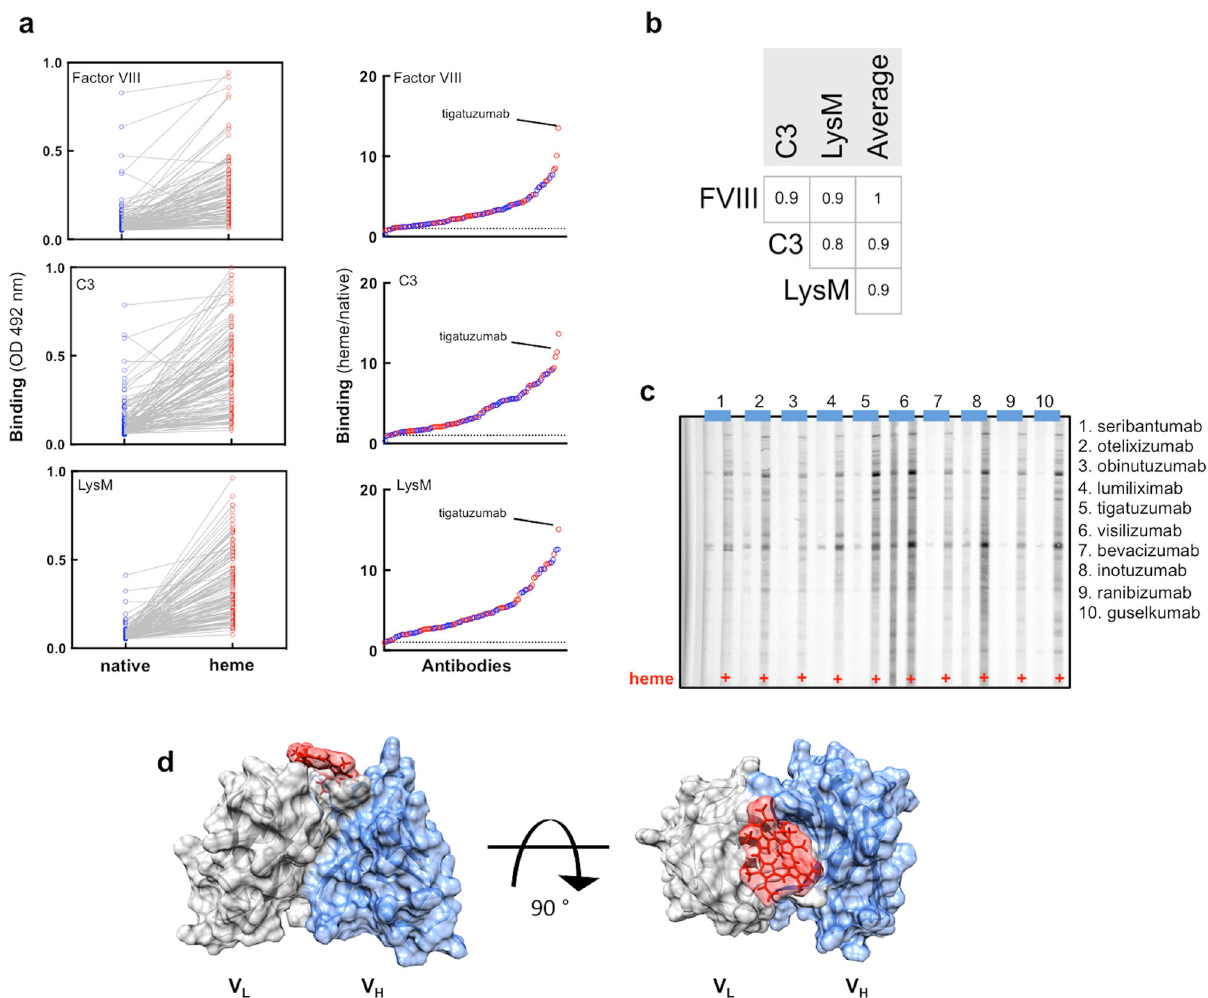
Fig. 3 Heme-induced antigen-binding polyreactivity of Abs. a ELISA analysis of the binding of the repertoire of therapeutic Abs to immobilized human (FVIII, C3) and bacterial (LysM AtlA) proteins. Each circle depicts the average reactivity of an individual Ab obtained from duplicate samples. The right panels show the global reactivity pro fi le of the repertoire of therapeutic Abs. The protein binding intensity was obtained by dividing the reactivity of given Ab after exposure to heme by the reactivity of the same Ab in its native form. The dashed line represents a twofold increase in the binding. The red circles represent Abs that are currently in clinical trials. The blue circles indicate the clinically approved Abs. b Correlation between reactivities of the therapeutic Abs to different protein antigens upon exposure to heme. Matrix depicts the correlation analyses between the reactivity of heme-treated Abs to different proteins and the average reactivity toward the three proteins. The correlation analysis was performed using Spearman ’ s rank-order test. The values of the correlation coef fi cients ( ρ ) are shown in the matrix. All P values are <0.005. The right panel illustrates the statistical signi fi cance ( P values). c Immunoreactivity of selected Abs (top 10 heme-sensitive Abs) toward antigens present in the total lysate of B. anthracis . d The three - dimensional structure of tigatuzumab was modeled by sequence-based variable region modeling algorithm RosettaAntibody implemented on ROSIE web server (http:// rosie.rosettacommons.org/). The putative heme-binding site was then predicted by docking of the protoporphyrin IX molecule to the variable region using the SwissDock web service protein – ligand docking platform-based on the EADock DSS algorithm (http://www.swissdock.ch/). The fi gure shows the side and top view of the variable region of tigatuzumab. Gray: variable domain of light chain; blue: variable domain of heavy chain. Heme is shown in